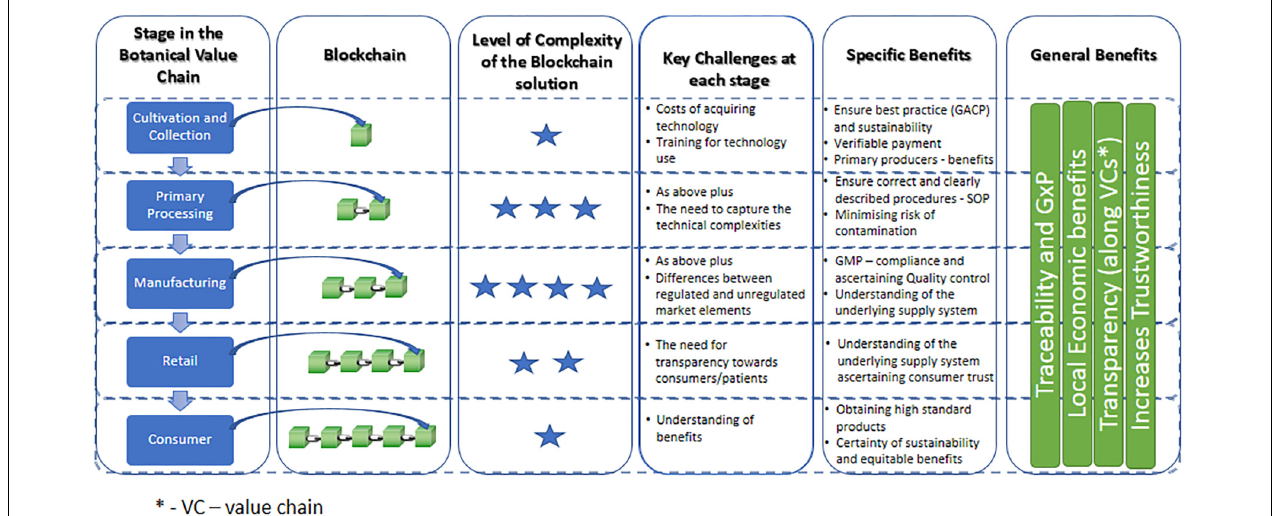
FIGURE 2 | A general overview of the various stages of value chains of botanical products and how these could be managed using blockchain systems. Levels of complexity range from low ( ) to very high (